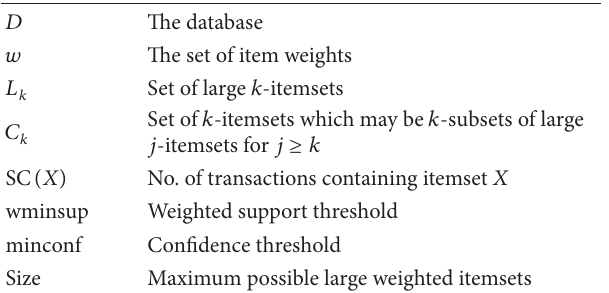
Table 4: Notations of Algorithm